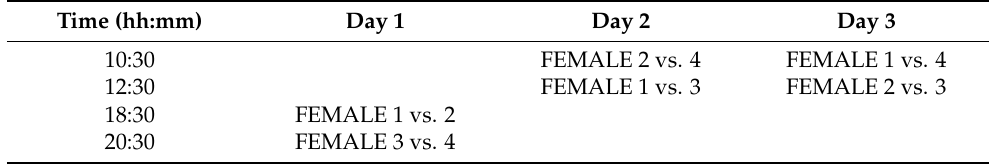
Table 1. Match schedule of the